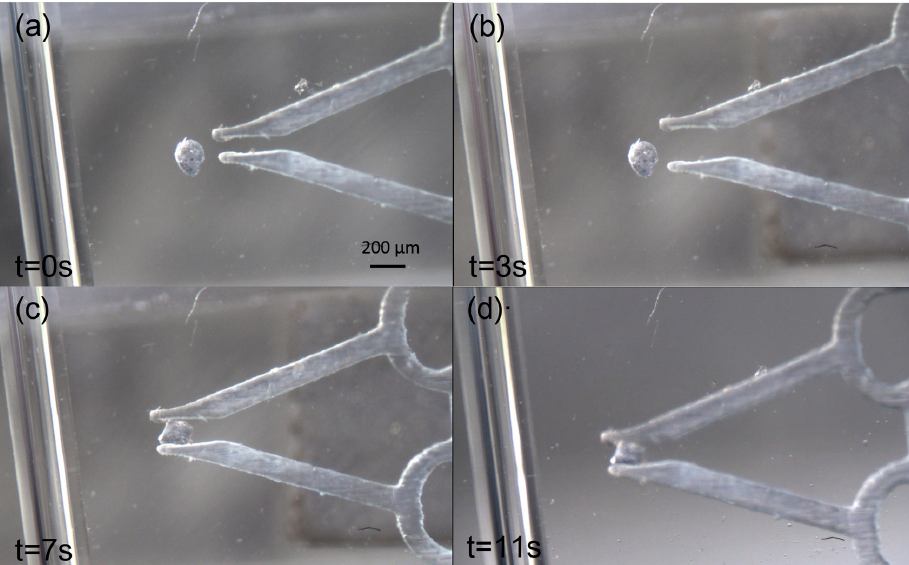
Figure 9. Sequential micrographs of the microgripper manipulation experiment. ( a ) The microgripper is in position to open and grip. ( b ) The microgripper opens under the action of a magnetic component force applied to the gripper. ( c ) The microgripper grips the particle by decreasing the component force. ( d ) The microrobot changes height (it appears dimmer in the image because it has risen in the fluid as a result of changes to the balanced magnetic and buoyancy